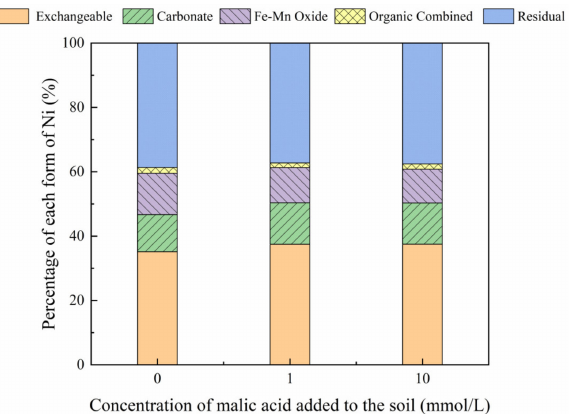
Figure 8. Distribution of different Ni forms in Ni-100 soil after the addition of malic acid (0, 1, 10 mmol/L).